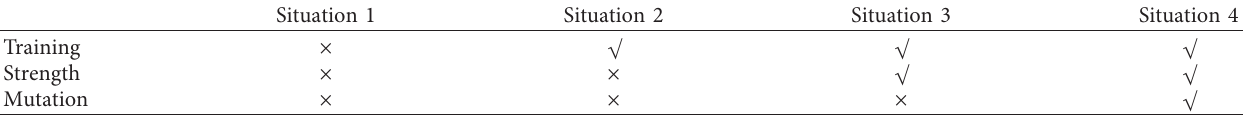
Table 3: Test of hybrid evolutionary algorithm.